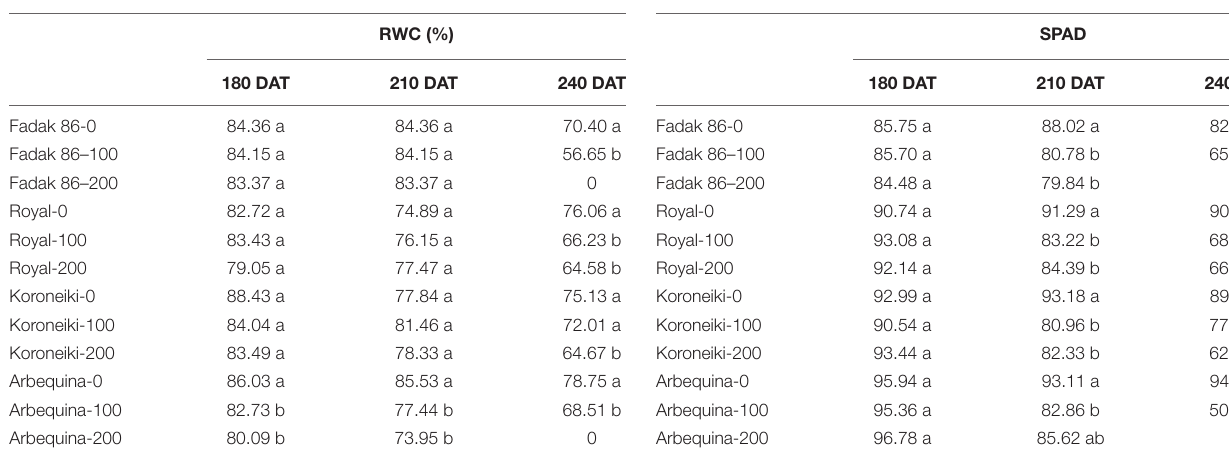
TABLE 2 | Relative water content of leaves in four olive cultivars treated with 0, 100, and 200 mM NaCl.